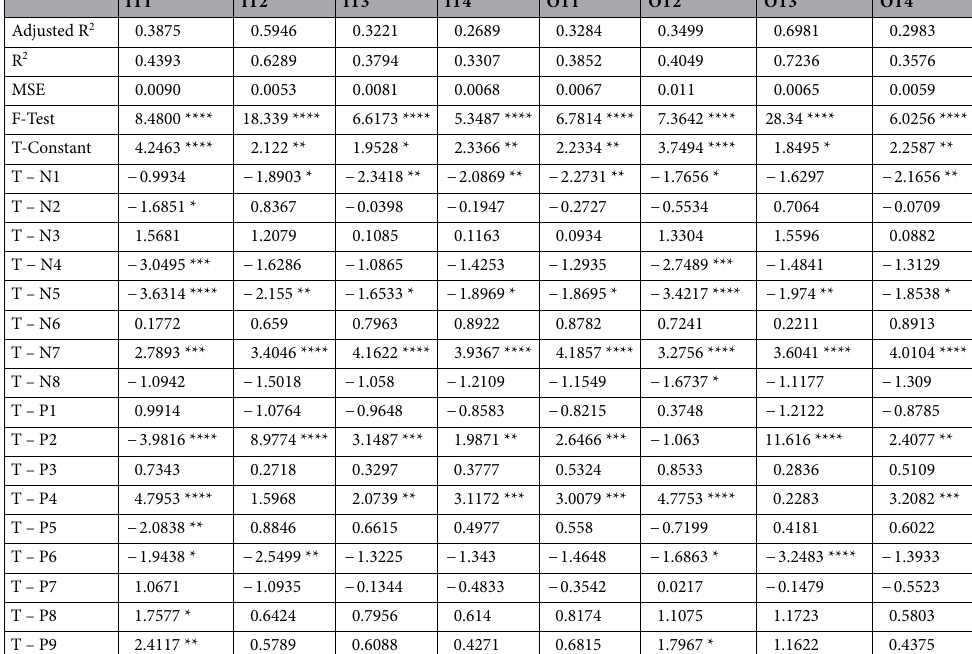
Table 9. MLR models results. Variance Inflation Factor (VIF) = 10.7532. If p value < 0.001 ⇒ ****; p value <